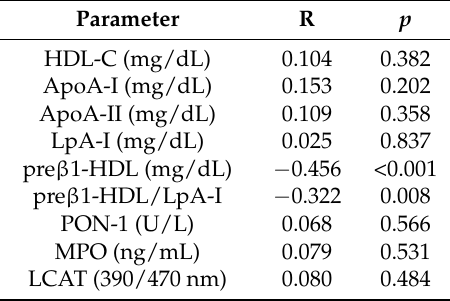
Table 2. Univariate correlation between HDL-related parameters and eGFR.